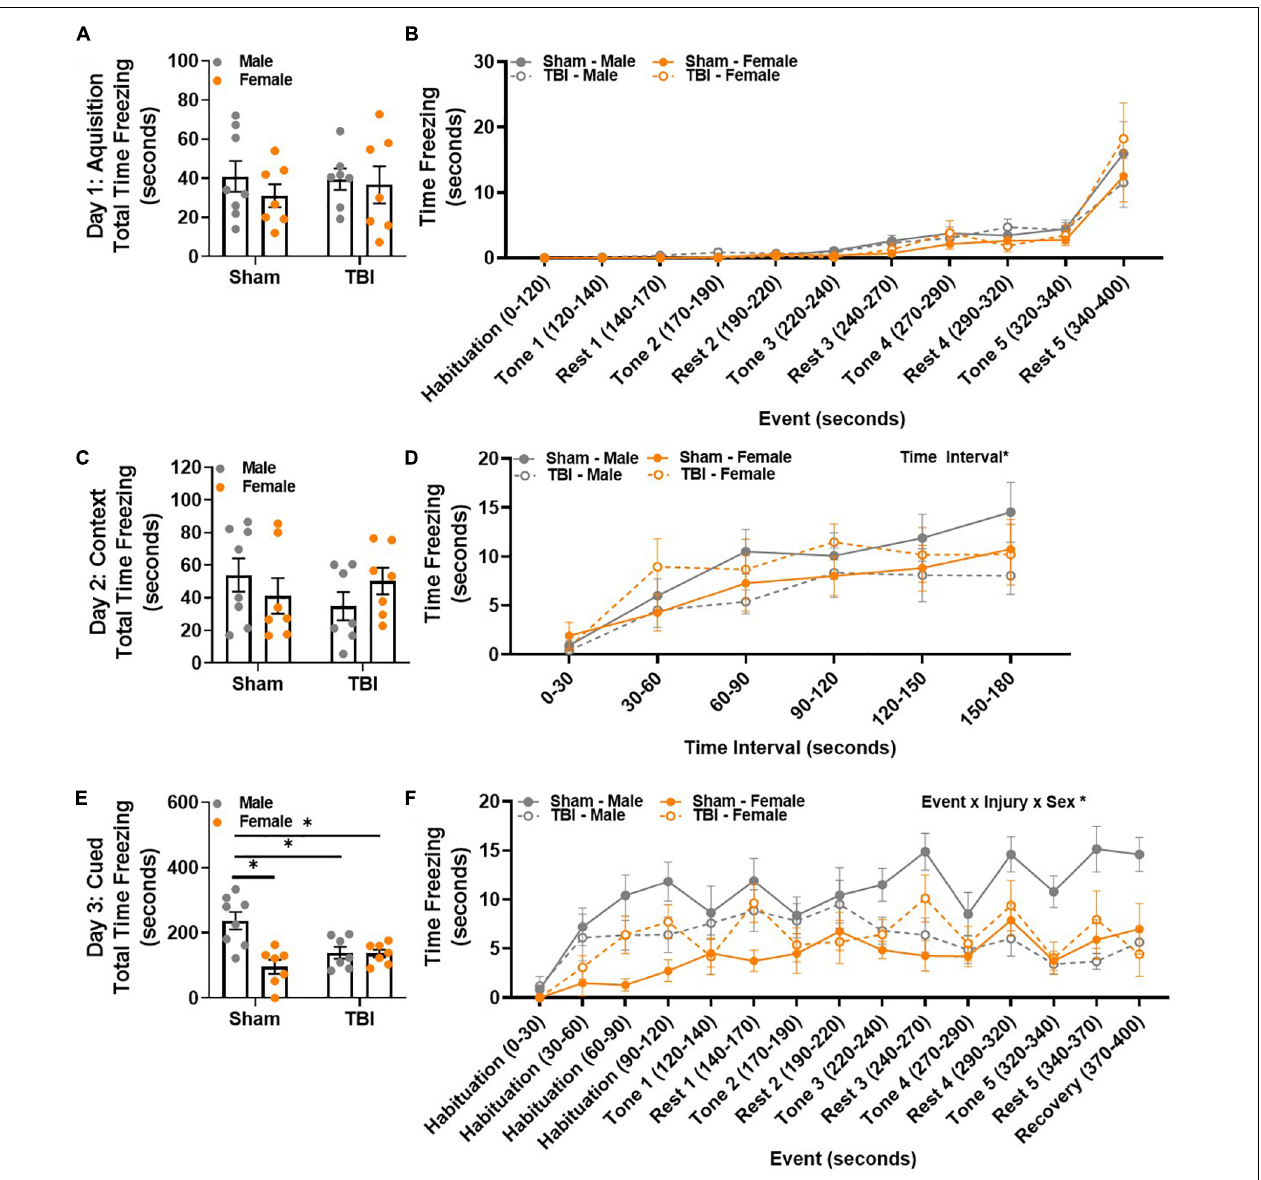
FIGURE 5 | TBI results in sex-specific retention deficits of fear memory 15 weeks post-injury. (A) Total time freezing was similar between all groups during the acquisition phase. (B) Freezing in response to tone-rest events was similar between all groups during the acquisition phase. (C) Total time freezing was similar between all groups during the contextual/extinction phase. (D) Freezing increased in all experimental groups over time. (E) Male sham mice spent the most total time freezing during the cued/retention phase. (F) Freezing in response to tone-rest events was uniquely influenced by both injury and sex, with male sham mice freezing the most over time. N = 7–8/group; error bars indicate SEM. Main effects are identified in the figure, unless an interaction effect was identified. ∗ p <